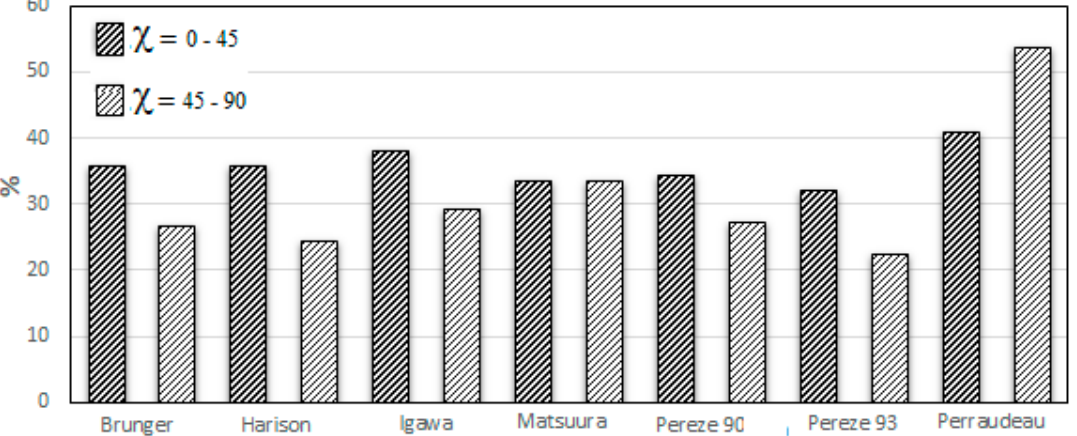
Figure 9. RMSE of the investigated models as a function of the angular distance between the sky point and sun, χ (0° to 90°).